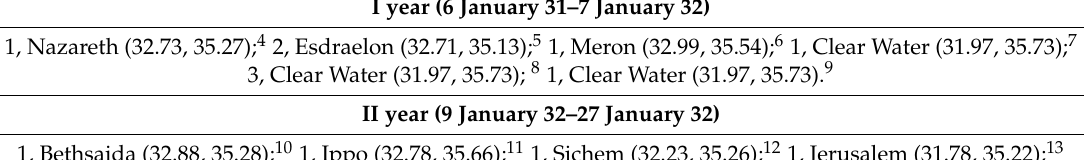
Table 3. Locality (latitude, longitude) where rain is reported according to the EMV in the years of Jesus’ public life, divided by year of Jesus’ public life. For each locality the first integers give the number of single or sequence of successive rainy